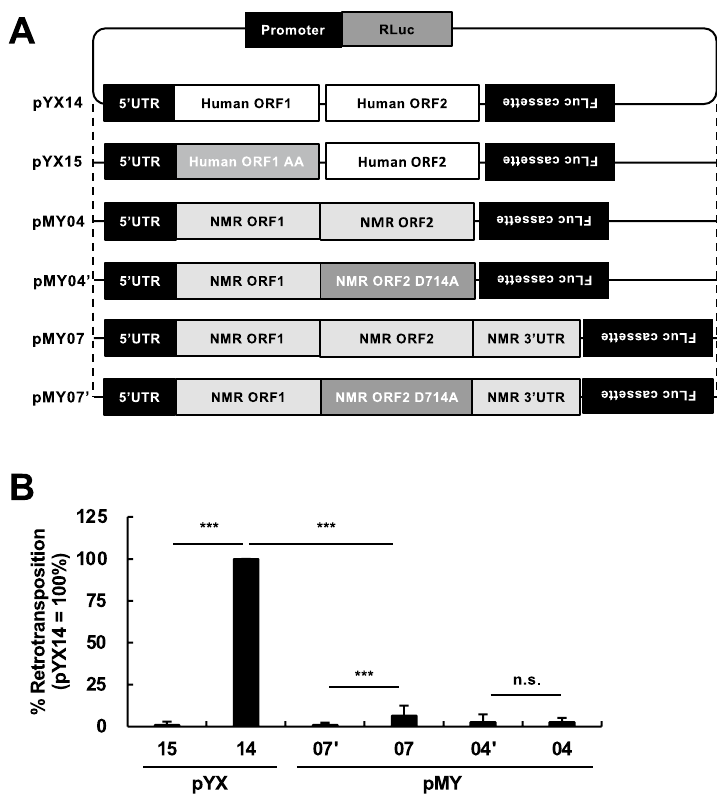
Figure 2. Characterization of the retrotransposition activity of NMR-L1. ( A ) Schematic view of the human L1 RP and NMR-L1 reporter plasmids. ( B ) The L1 retrotransposition activity of NMR-L1 with and without the 3 ′ UTR. 293T cells were transfected with the indicated L1 reporter plasmids. Luciferase activity level in